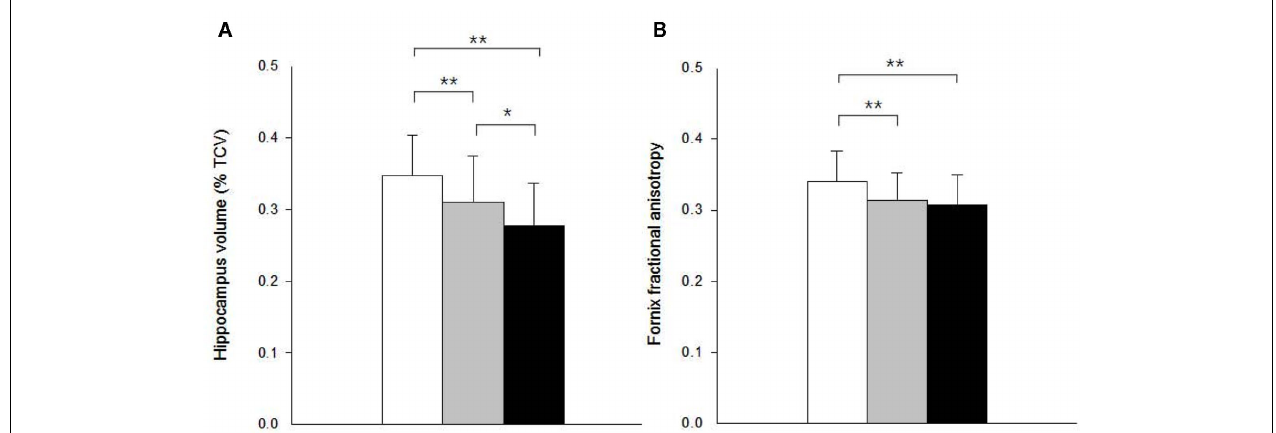
individuals; gray columns, patients with mild cognitive impairment (MCI); and black columns, patients with Alzheimer’s disease (AD). Error bars indicates